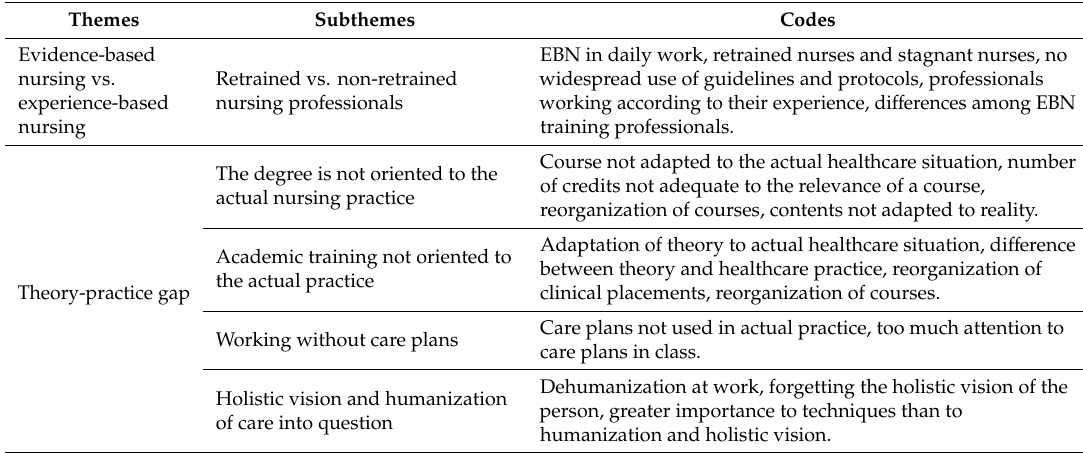
Table 3. Themes, subthemes, and